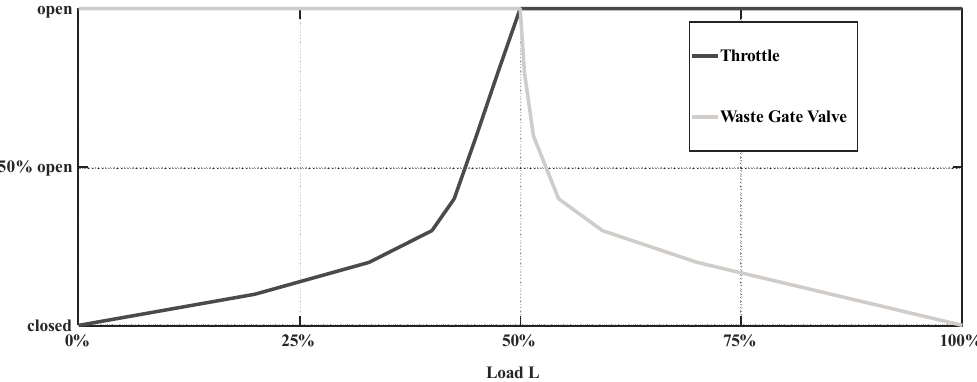
Fig. 3. Load control strategy, which is implemented on the ECU